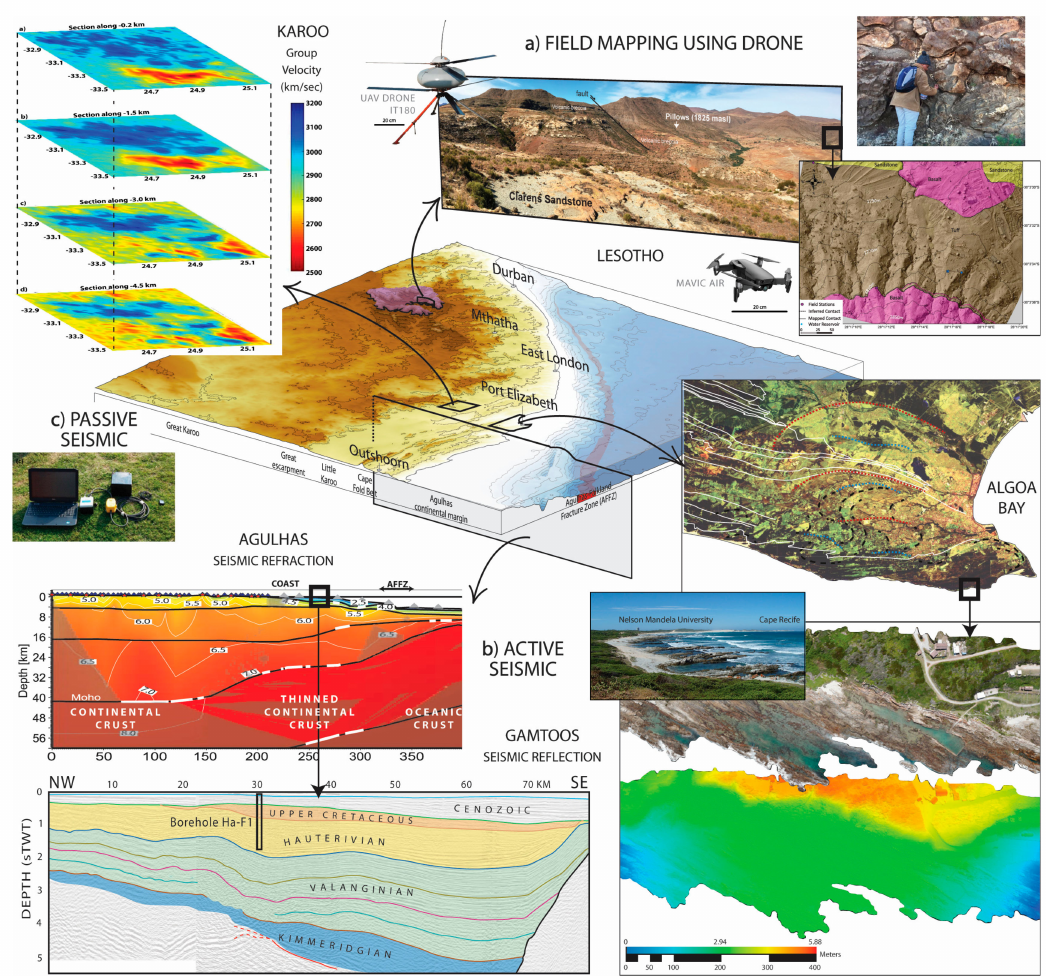
Figure 4. Geological and geophysical data collecting methods across the south-eastern corner of the South Africa margin (ETOPO 2 min precision elevation model), from the Drakensberg Mountains, ca. 3500 m above sea level (asl), to the abyssal plain of the southwest Indian Ocean, ca. 5000 m below sea level (bsl): ( a ) Mapping the paleo-coastline in Lesotho and the modern rocky shore near Port Elizabeth using satellite, drone, and field surveys; ( b ) interpreted seismic refraction and reflection profiles imaging the structure of the crust onshore and o ff shore; and ( c ) passive seismic tomography in the Karoo hinterland, based on ‘sound of waves’ from the ocean (see text for